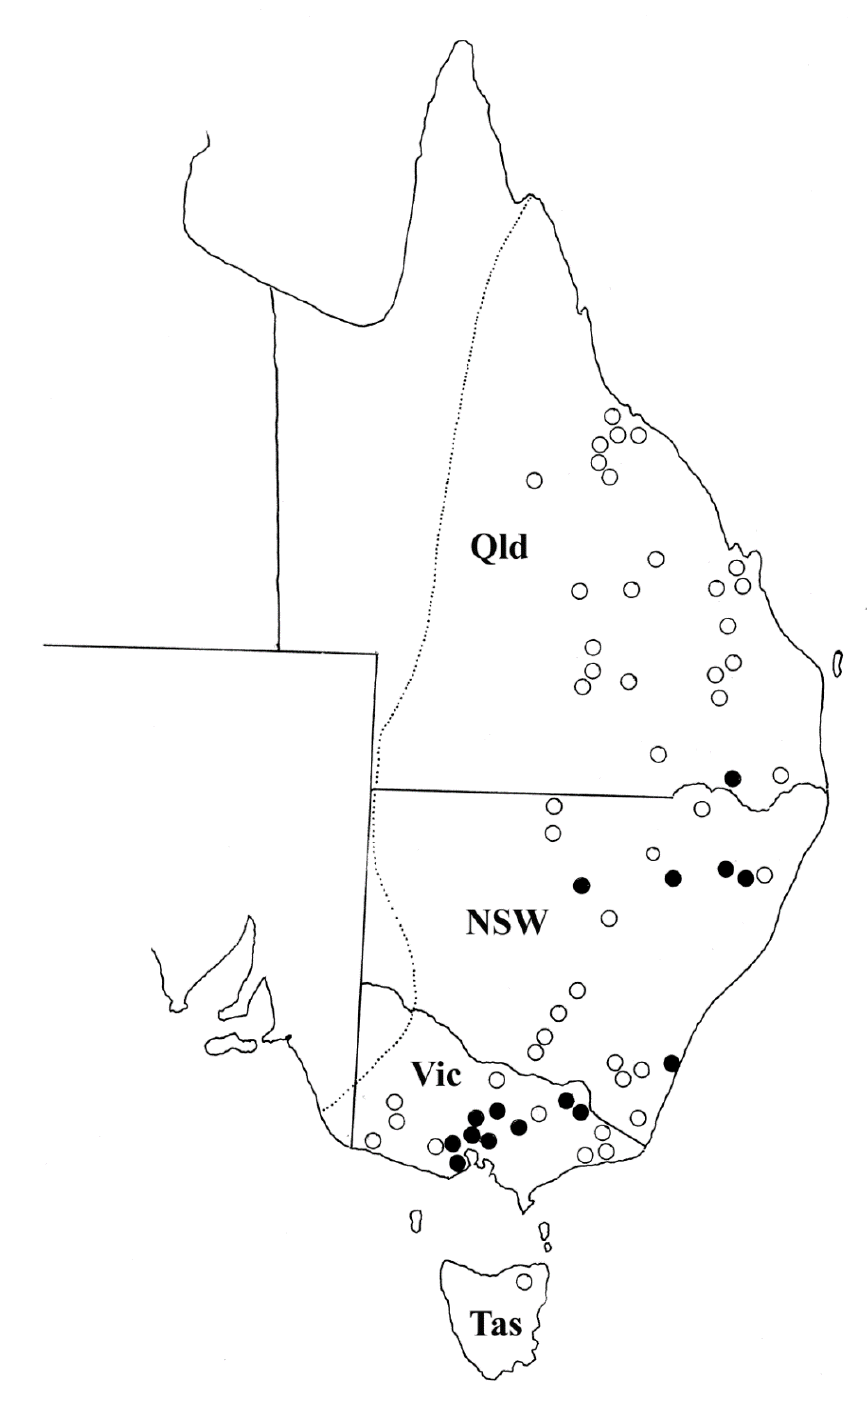
Figure 4. The geographic distribution of Torquenema toraliforme n. comb. The dotted line represents the distribution of the host, Macropus giganteus based on Van Dyck and Strahan [9]. Open circles represent locations in which hosts have been examined but T. toraliforme was absent. Solid circles represent locations in which T. toraliforme was found. Abbreviations; Qld = Queensland, NSW = New South Wales, Vic = Victoria, Tas = Tasmania.